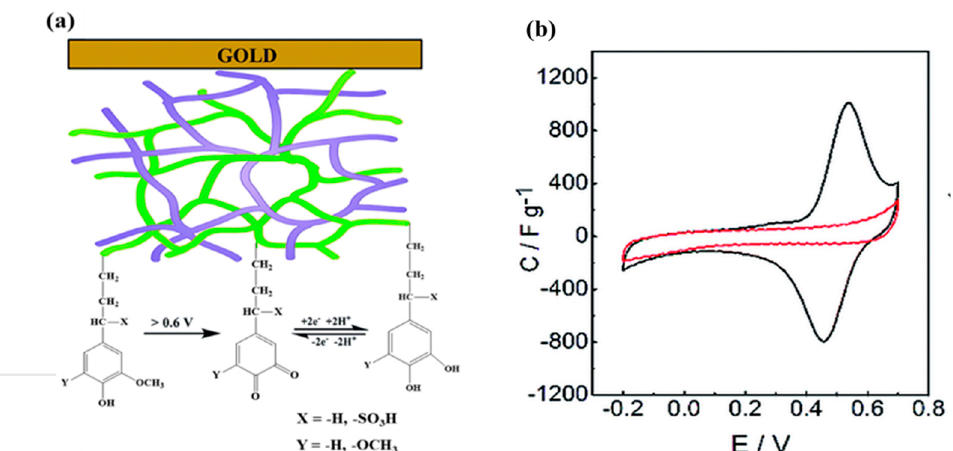
Figure 6. ( a ) Schematic representation of an interpenetrating network of PPy/lignin on an Au substrate, formed through electrochemical polymerization of pyrrole in the presence of lignin. Green lines: lignin with the redox e − /H + exchange reaction; purple lines: PPy. ( b ) CV traces of PPy (red) and the PPy/lignin composite (black). Reprinted with permission from ref. [47]. Copyright 2015 Royal Society of Chemistry.